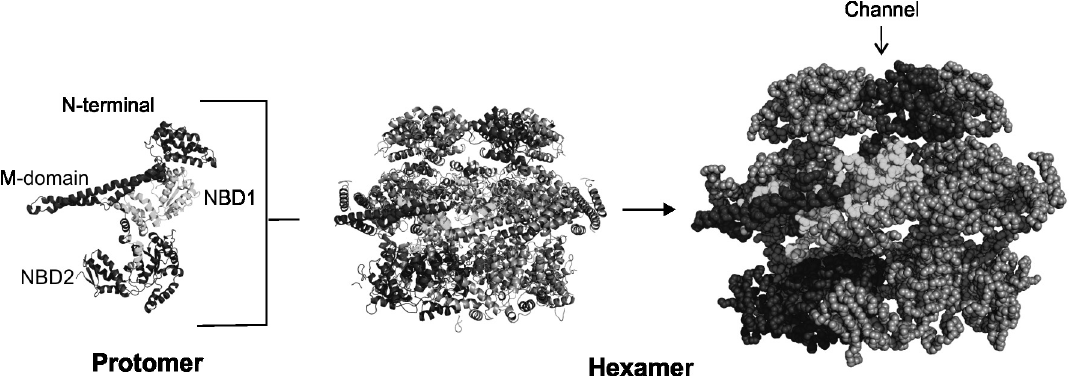
Figure 4 - Hexameric model for the Hsp100 family. Protomer cartoon representation of the structure of ClpB from Thermus thermophilus (PDB accession number 1QVR); hexamer cartoon and sphere representation (PDB accession number 4D2U) with detached protomer and the channel. Gray patterns in left are maintained: N-terminal, NBD1, M-domain and